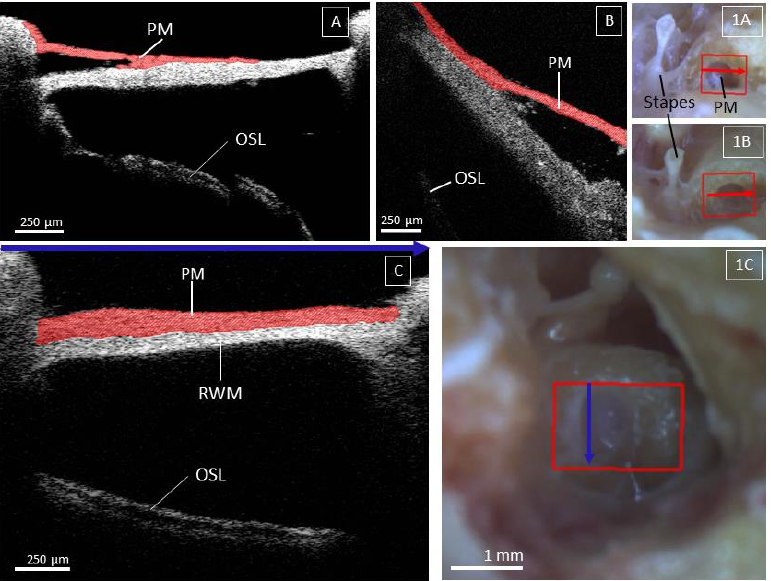
Figure 7. Visualization of pseudomembrane (PM) on top of the round window membrane (RWM). Figure ( 1A , 1B , 1C ) are the corresponding microscopic images, with the blue and red arrows corre- sponding to the cross-section of the OCT images, indicated by the blue arrow at the top of figure ( C ). The shape, orientation, and extent of the PM were different across all samples and are illustrated in the Figure. ( A , 1A ) show a PM covering the RWM at the superior rim. ( B , 1B ) show a PM at the anterior rim of the RW niche, limiting the view onto the underlying OSL. ( C , 1C ) show a PM covering the entire RWM; due to the perpendicular axis of the internal structures towards the OCT beam, the OSL is still visible; however, it is less reflective. ( A – C ) have an a-scan rate of 10, 76, and 28 kHz, respectively. Abbreviations: Round window membrane (RWM), Pseudomembrane (PM), Osseous spiral lamina